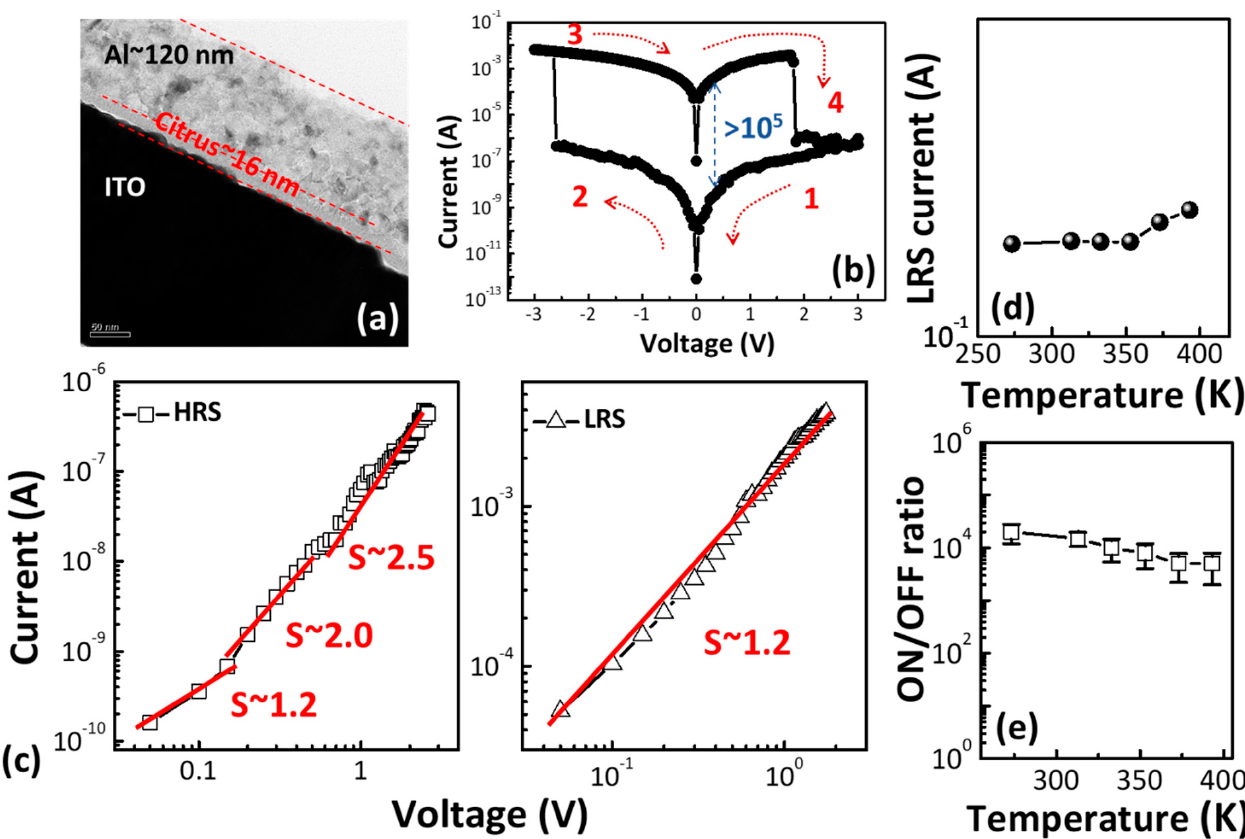
Figure 2. ( a ) TEM cross-section micrographs and ( b ) the typical current–voltage ( I–V ) characteristics of the Al/C1/indium tin oxide (ITO) structure. The bias sweep sequence is indicated by the arrows. ( c ) Double logarithmic plots of the high resistance state (HRS) (left) and low resistance state (LRS) (right) of the C1 memory device. ( d ) Temperature dependence of the LRS current of the C1 memory device. ( e ) The ON/OFF ratio as a function of the temperature from 273 to 393 K.